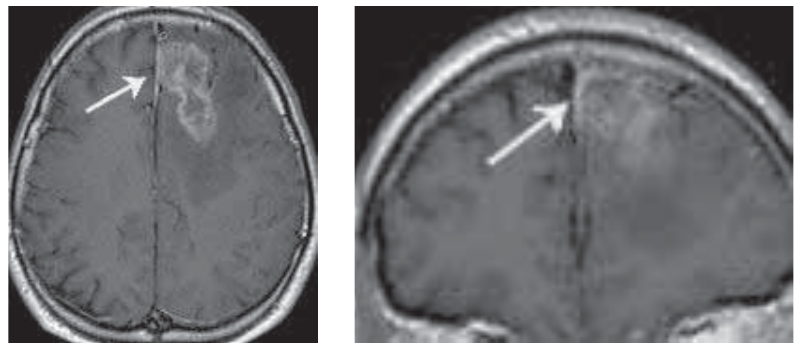
FIGURE 3 and 4. The axial and coronal contrast-enhanced T1-weighted images show the dural multiformetorium.